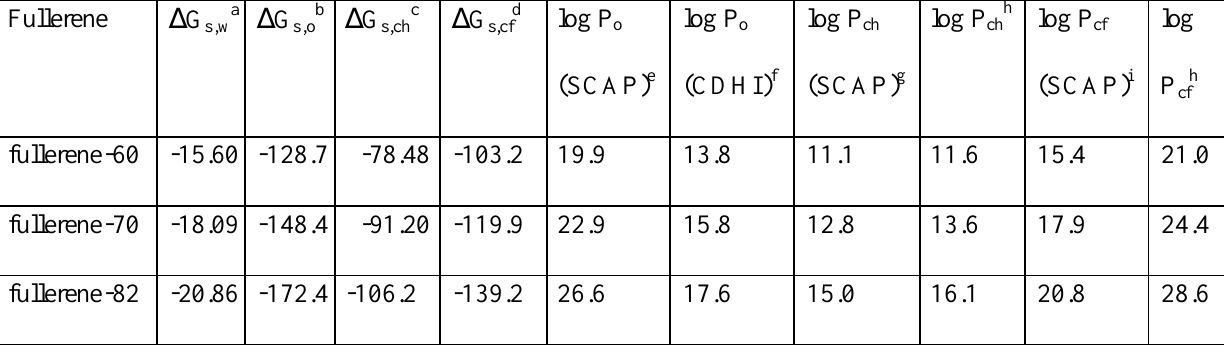
Table 5. Solvation descriptors for fullerene-60, -70 and -82.